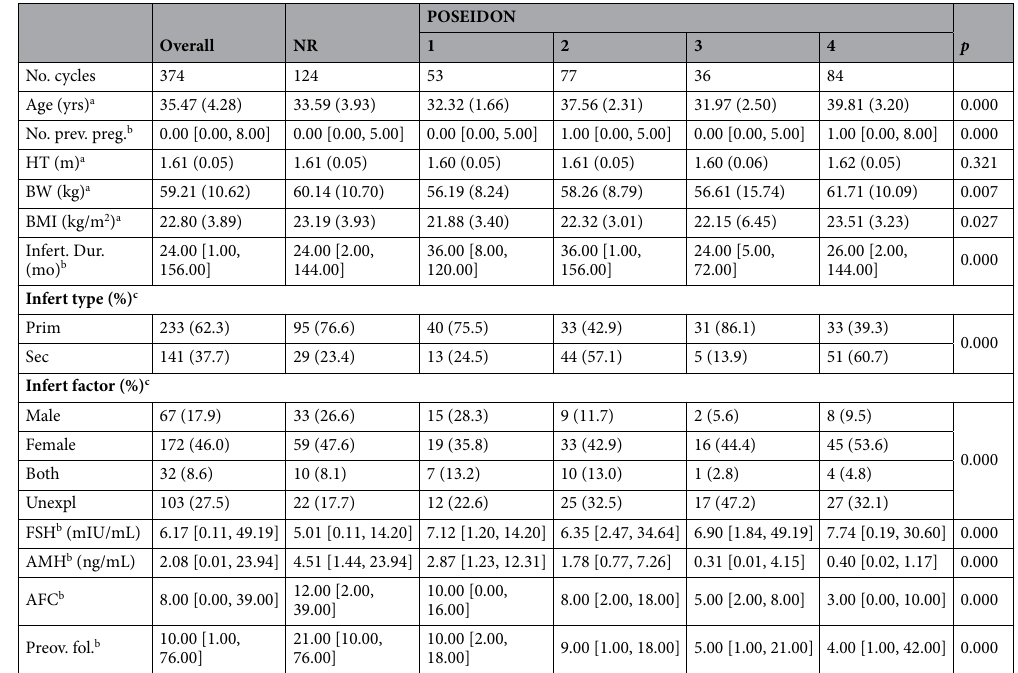
Table 1. Patient characteristics in all performed cycles. Continuous variables are presented as either a mean (SD) or b median [interquartile range]. Categorical variables are presented as c number of cycles (%). A p-value < 0.05 was considered statistically significant. NR normal responder, No. number, yrs years, prev. previous, HT height, BW body weight, BMI body mass index, Infert . Infertility, Dur. Duration, mo months, prim. Primary, sec. secondary, unexpl. Unexplained, FSH follicle stimulation hormone, AMH anti-Mullerian- hormone, AFC antral follicle count, Preov. fol. preovulatory follicles, POSEIDON patient-oriented strategies encompassing individualized oocyte